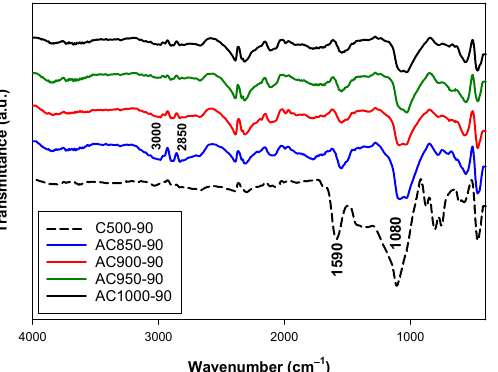
Figure 16. FTIR spectra of the obtained activated carbon. The blue, red, green, and black solid lines refer to activated carbon prepared at 850, 900, 950 and 1000 ◦ C for 90 min. The black dash line is the char carbonized at 500 ◦ C. All carbon samples were derived from char carbonized at 500 ◦ C for 90 min.